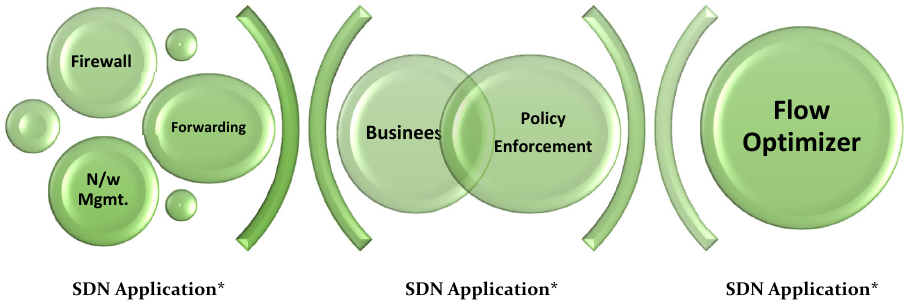
Figure 5. Workflow of application plane.